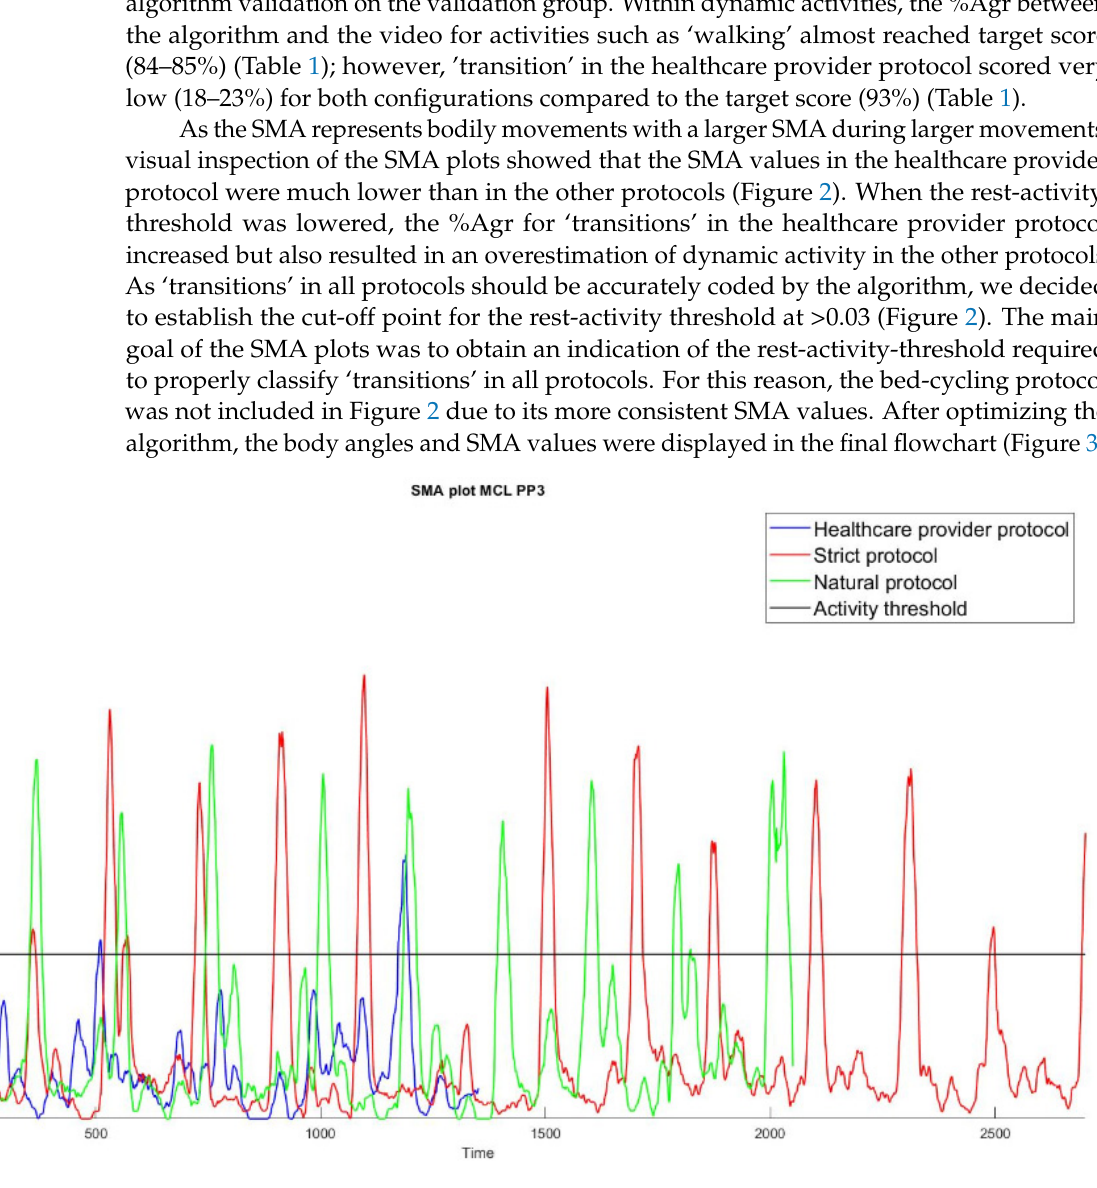
Figure 3. Flow chart of the developed algorithm for classification of the different activities based on body-segment-angles and SMA values of the different accelerometers. Activities in yellow and red are related to smaller and larger bodily movements, respectively. Abbreviations: SMA = signal mag- nitude area, MC = midclavicular accelerometer, T = thigh accelerometer, θ = theta, ψ = psi, φ = phi.